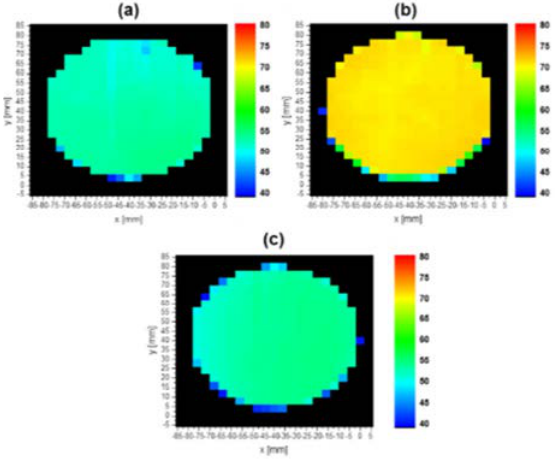
Fig. 4. Spatial mapping of the diffraction efficiency in -1 st order of the prototype flat grating for three different wavelengths, i.e. 376 nm (a), 600 nm (b) and 1000 nm (c).